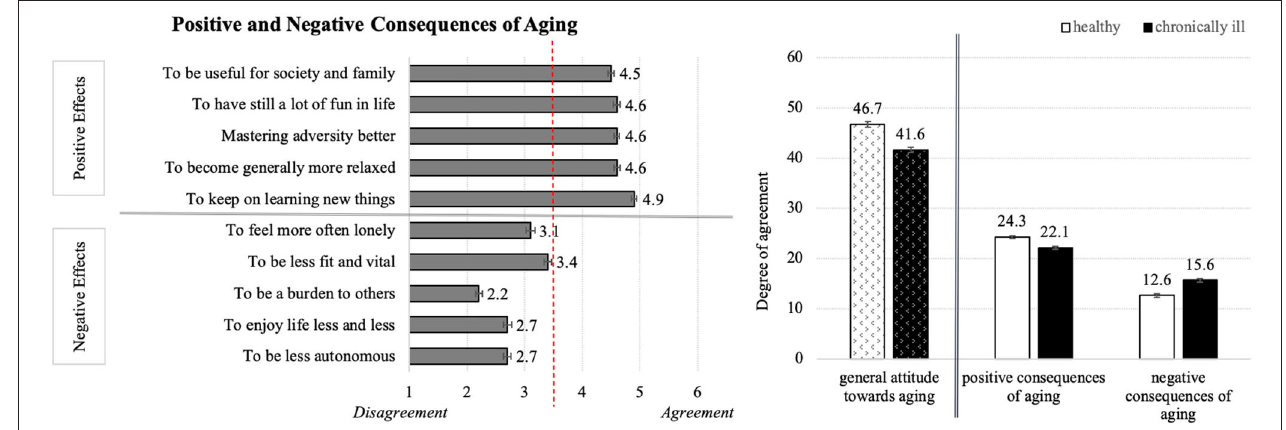
FIGURE 2 | Perceptions of positive and negative consequences of aging (Left) and the effect of health status on the general attitude toward aging ( Right ; N = 384).